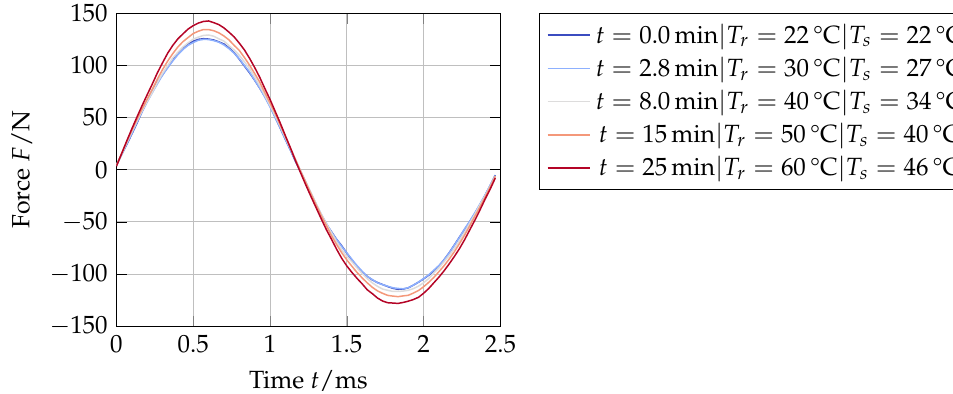
Figure 13. Measured force values at f = 400Hz plotted over one period at different time points and